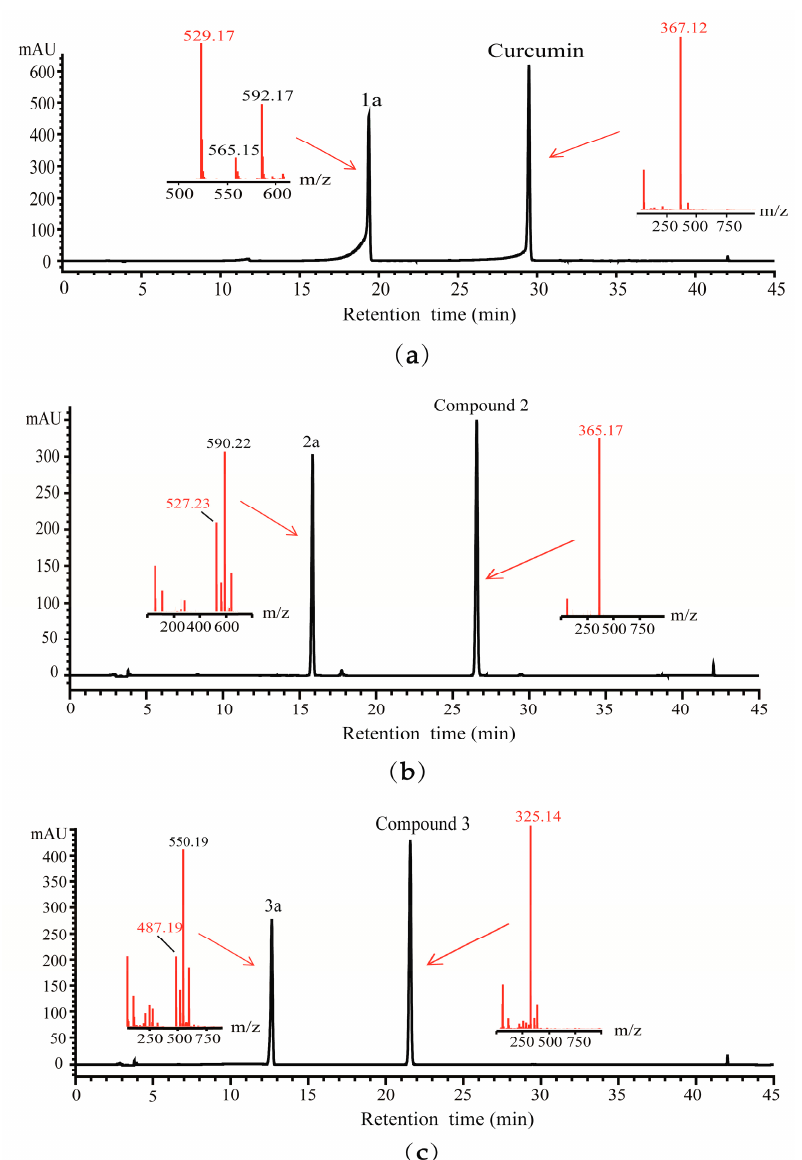
Figure 3. HPLC analysis of the glucoside derivatives of curcumin 1 ( a ) and its analogues 2 ( b ) and 3 ( c ) catalyzed by BsGT1 , and QTOF-MS analysis of those catalyzed by BsGT1 and BsGT2 (red numbers are molecular ion peaks [M-H] − of glucoside derivatives and substrates).